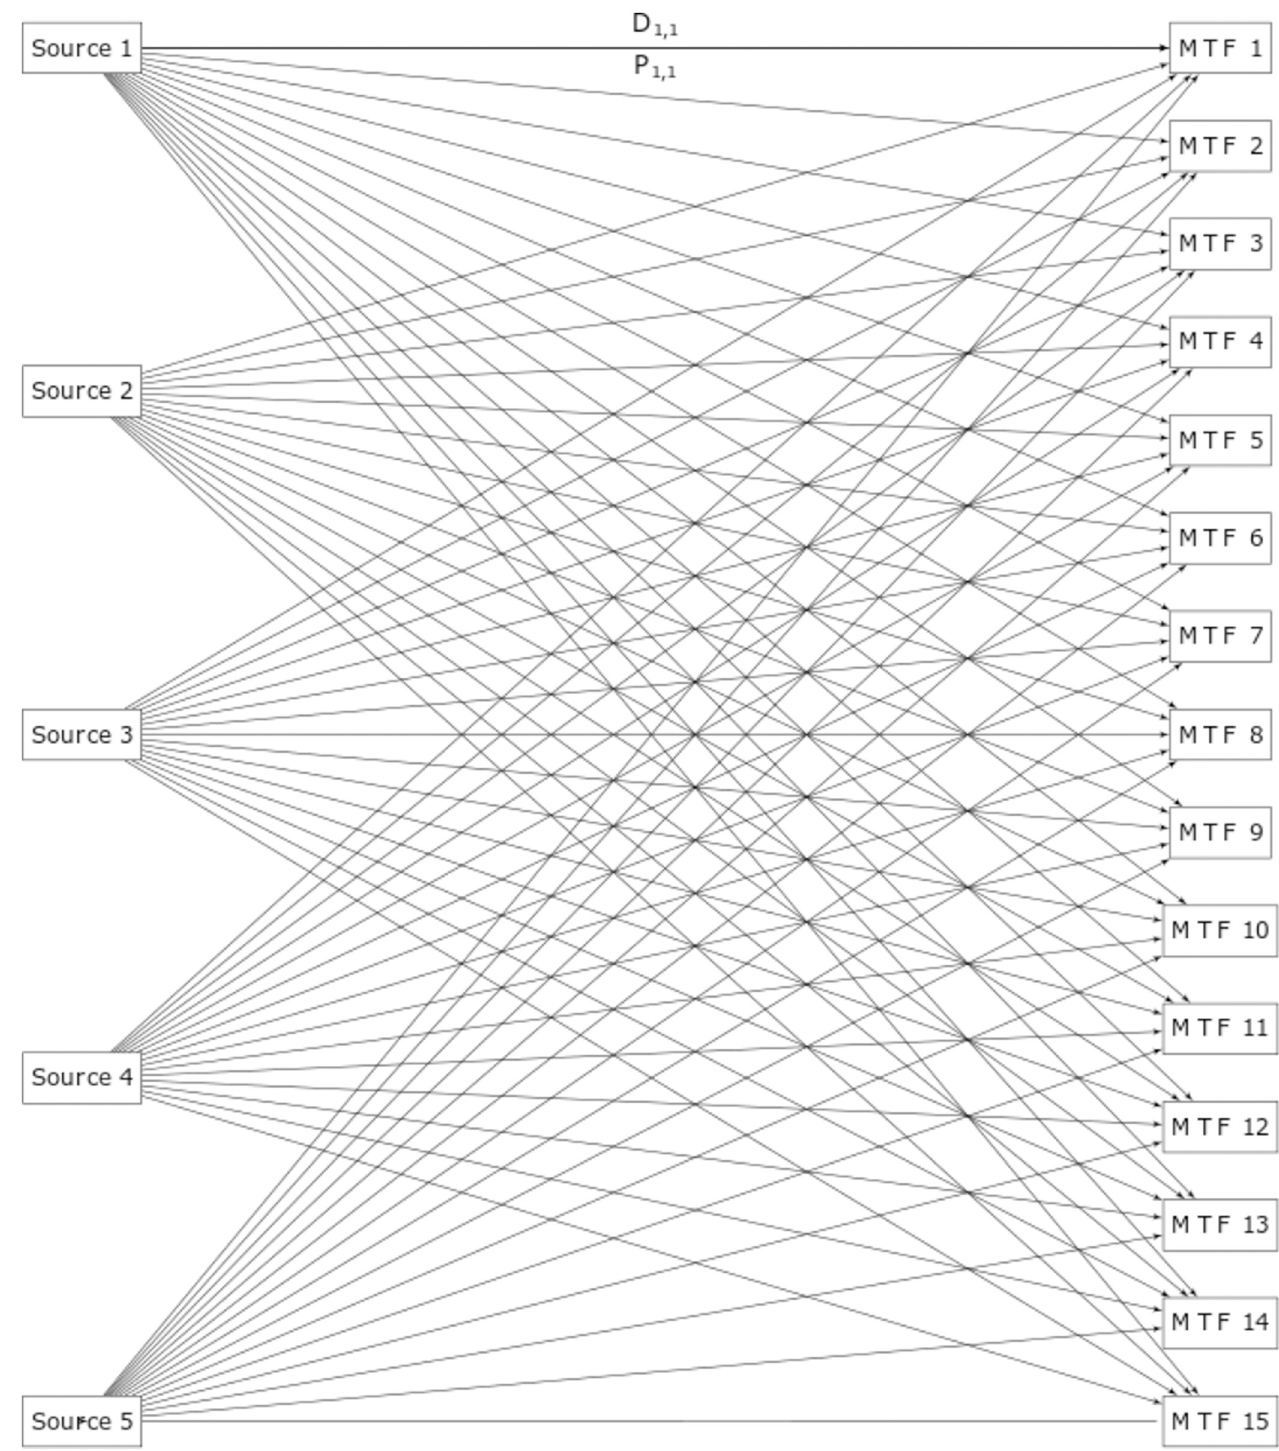
Fig 1. MTF network connectivity. D i , j is the distance between Source i and MTF j and P i , j is the probability that a given casualty generated by Source i will be directed to MTF j (for clarity only the labels between Source 1 and MTF 1 are shown).